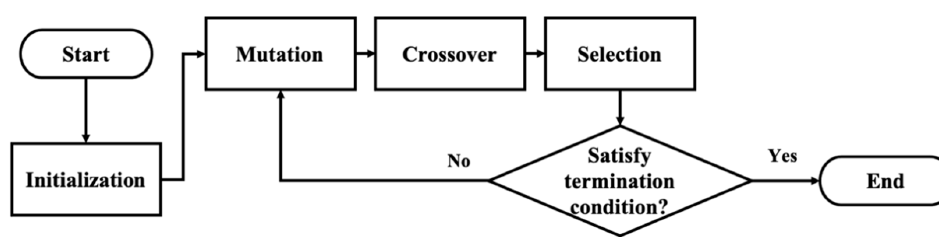
Figure 10. Flow chart of the DE algorithm.